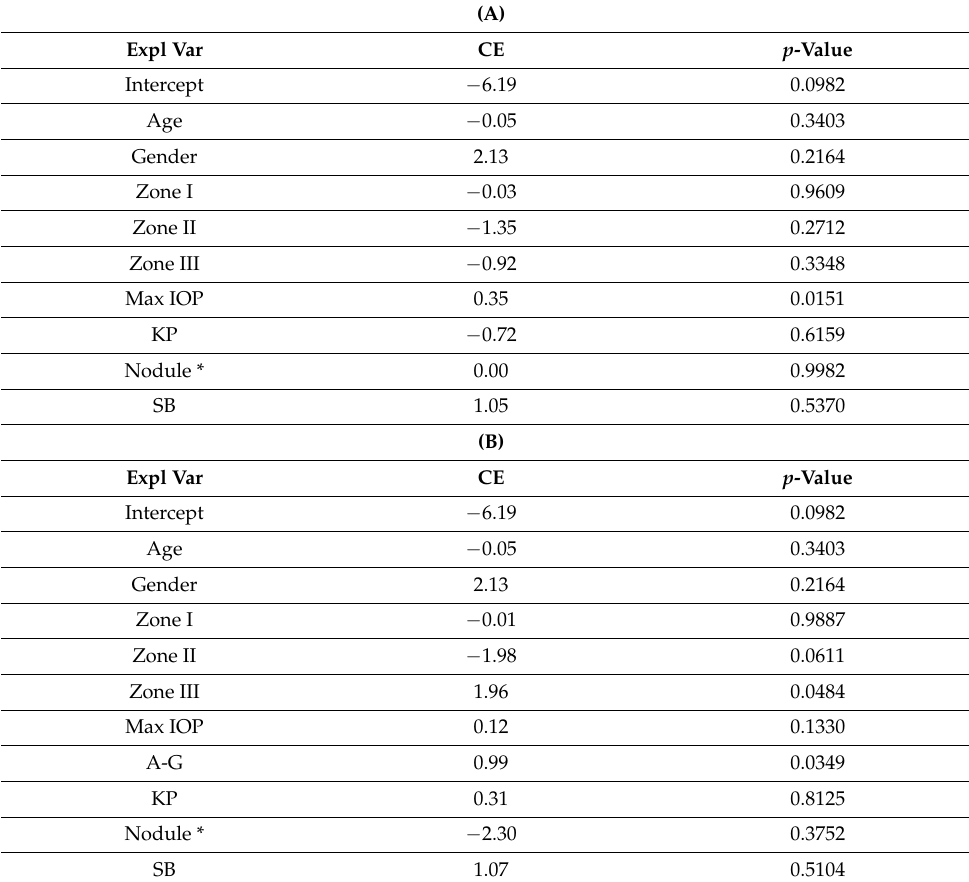
Table 5. ( A ) Logistic regression analysis of VFD in Aulhorn-Greve (A–G) among the different parameters (i.e., patient age, gender, number of manifestations in the three different zones, KPs, nodule in the angle, and snowball opacity) as evaluated by the Hosmer-Lemeshow test; ( B ) Logistic regression analysis of glaucoma surgery among the different parameters (i.e., patient age, gender, number of manifestations in the three different zones, KPs, nodule in the angle, and snowball opacity) as evaluated by the Hosmer-Lemeshow test. (A) Expl Var CE p -Value Intercept − 6.19 0.0982 − 0.05 0.3403 2.13